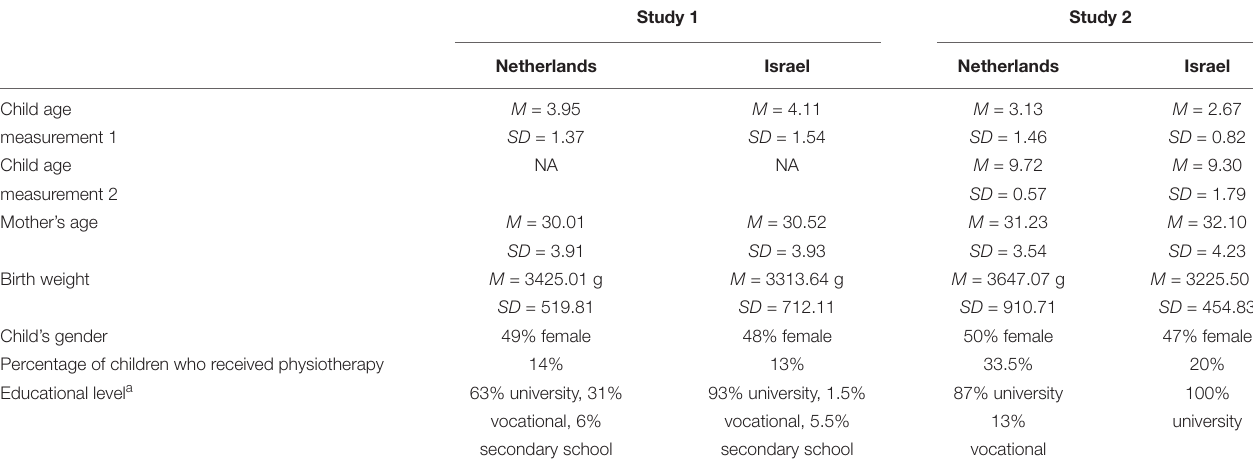
TABLE 1 | Main background variables in the two